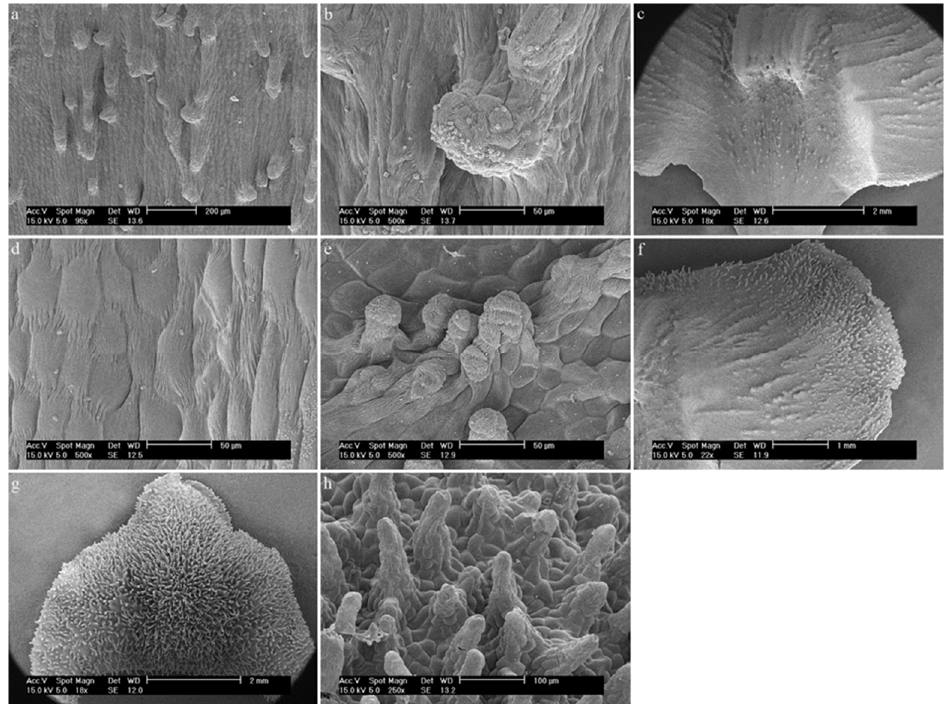
Figure 12. Dendrobium scoriarum W.W.Sm.: ( a ) the hypochile part of the labellum; ( b ) trichome of the hypochile part of the labellum; ( c , d ) the final part of the hypochile of the labellum/initial part of the mesochile of the labellum; ( e ) trichomes of the margin of the mesochile part of the labellum; ( f ) the mesochile part of the labellum; ( g , h ) trichomes of the epichile part of the labellum.